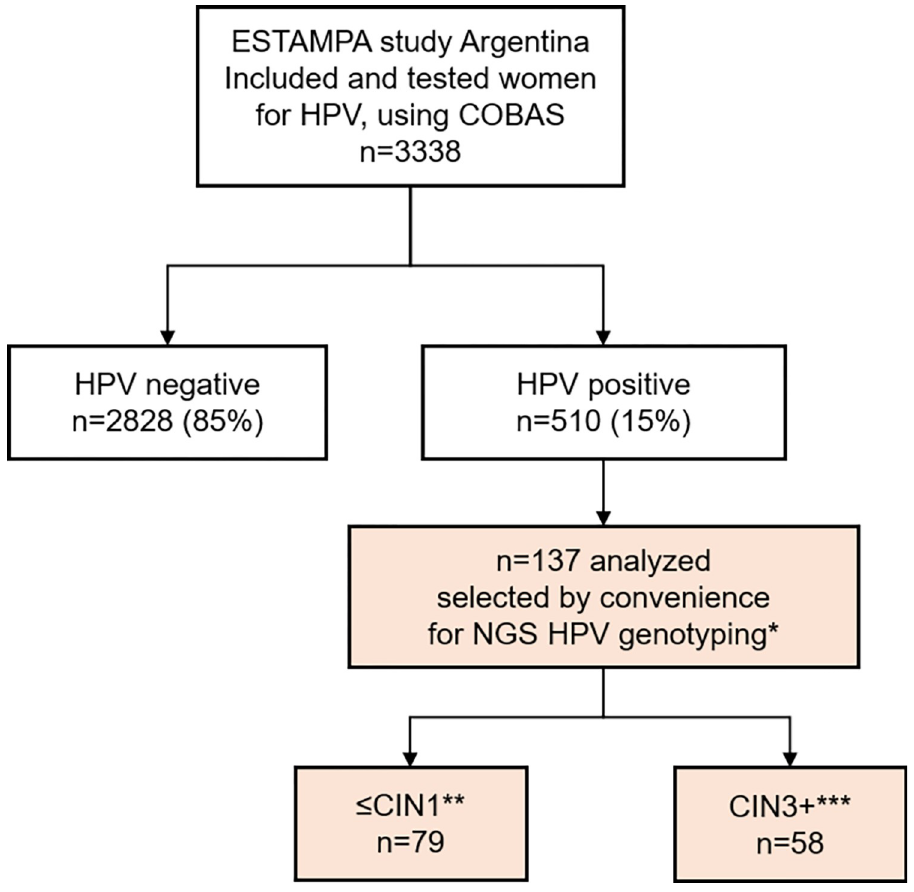
Fig 1. Selection of the study population. � All 137 samples had previously been genotyped for PCR/RBH. �� � CIN1: Normal Cytology (Negative for Intraepithelial lesion or Malignancy, NILM) and CIN1. ��� CIN3+: CIN3 and CC.